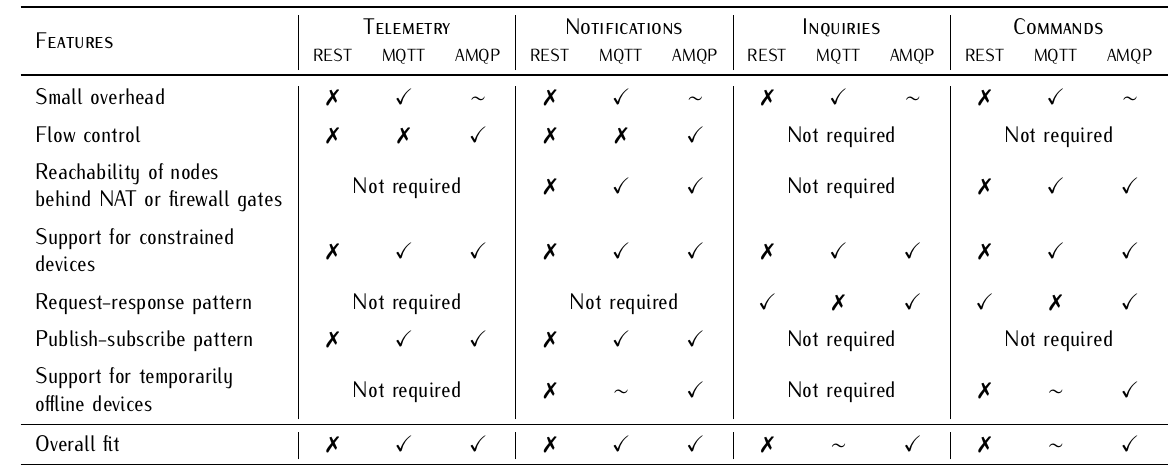
Table 2. Features of the various communication patterns and their support by the considered protocols. ( (cid:88) : fully supported; ∼ : partially supported; (cid:55) : not supported.)